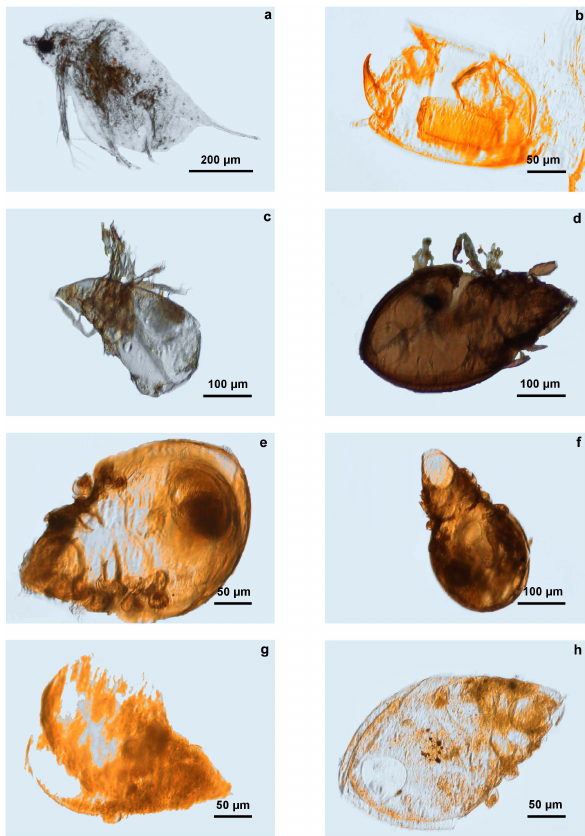
Fig. 3. Light microscope photographs of the identified fossil in- vertebrates in the cave sediments in Slovenia: (a) Daphnia sp.; (b) Orthocladiinae; (c) Dissorhina n. sp.; (d) Zygoribatula frisiate ; (e) Miracarus n. sp.; (f) Opiella (cf. Rhinoppia ) n. sp. 1; (g) Sucto- belbella sp. ?; (h) Oppiella ( Rhinoppia ) n. sp.